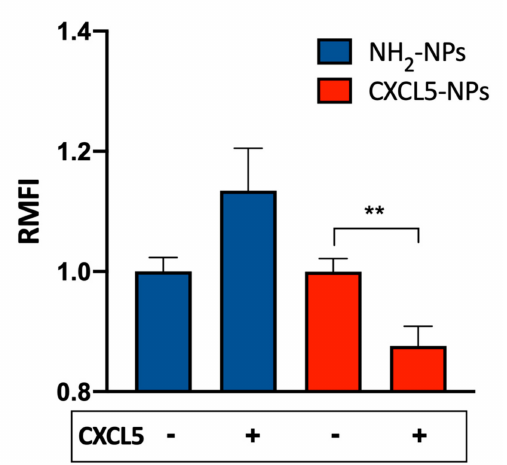
Figure 5. CXCL5 displacement by free CXCL5. Internalization of 50 µ g / mL NPs in THP-1 cells pretreated or not with 1 µ M CXCL5. The bars represent the relative median fluorescence intensity (RMFI) of at least three independent experiments ± standard error of the mean (SEM). ** p <